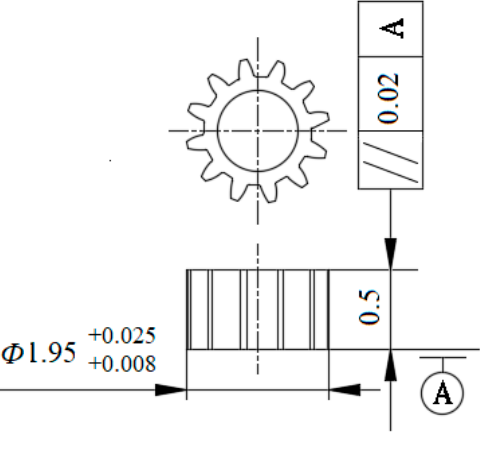
Figure 1. Part drawing of micro gear. Table 1. Performance parameters of workpiece materials.